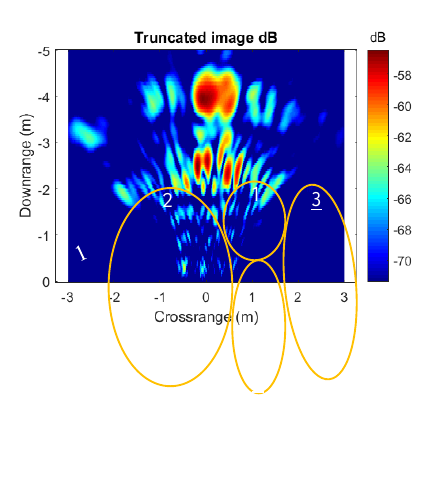
Figure 4. SAR image using (a) 1 pulse (b) 10 integrated pulses (c) 30 integrated pulses (d) 40 integrated pulses in dB